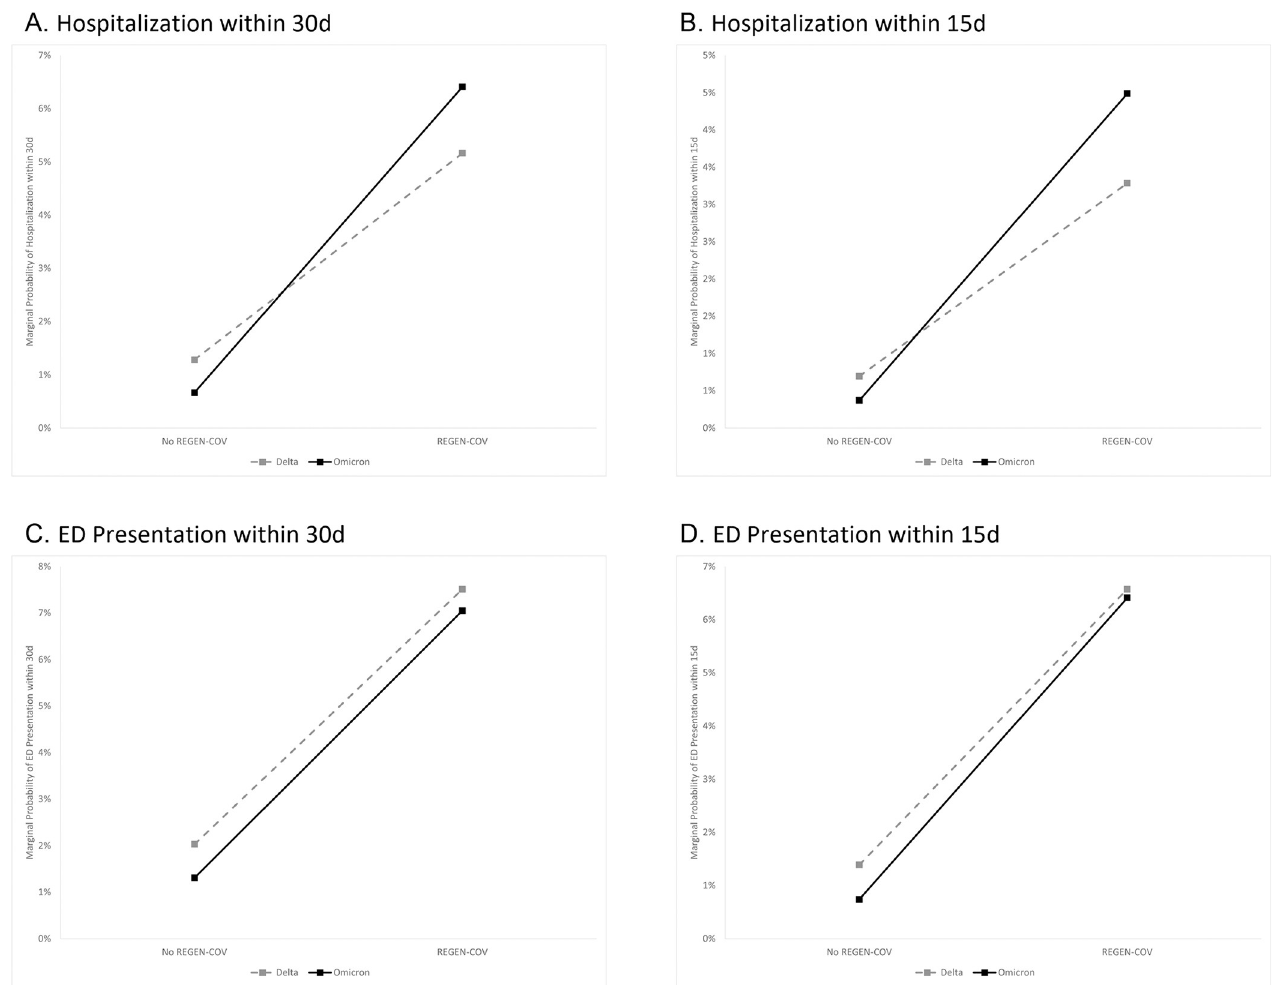
Fig 1. Marginal probability of outcomes by time period and REGEN-COV receipt. A. Hospitalization within 30d. B. Hospitalization within 15d. C. ED Presentation within 30d. D. ED Presentation within 15d. d: days; ED: emergency department.